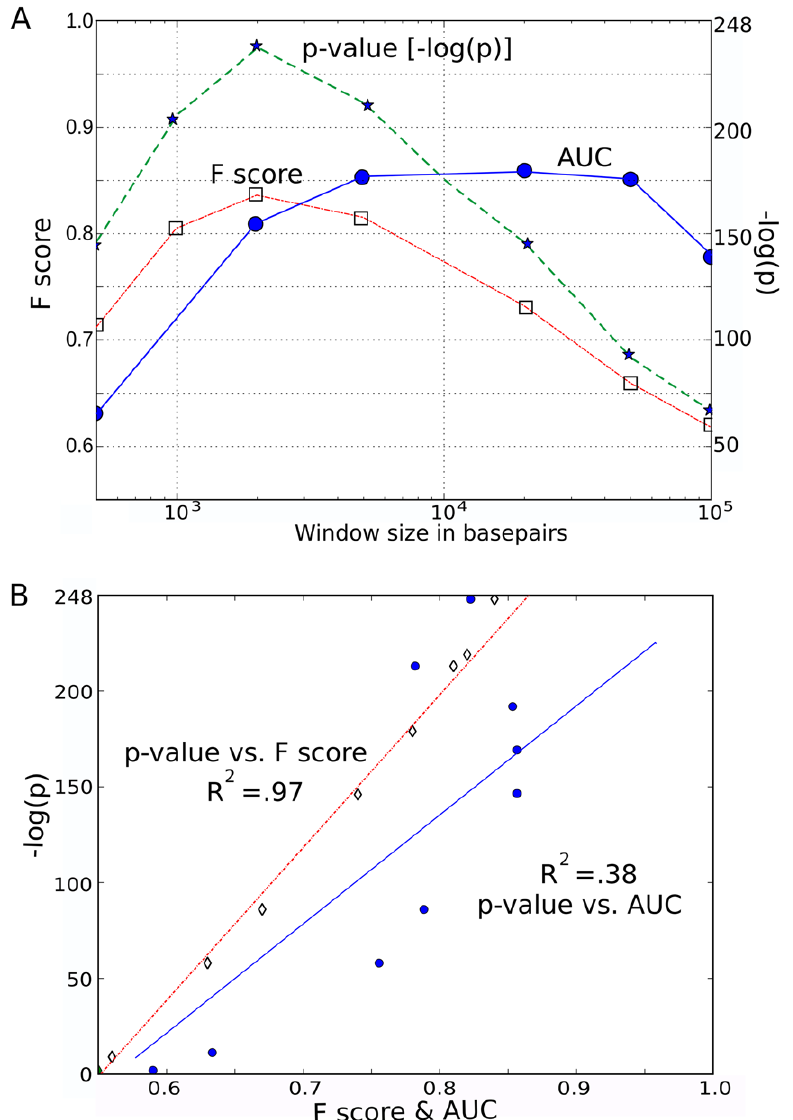
Figure 7. Effect of the window size on F score. ( A ) Plot of Area Under Curve (AUC) or F score (both on left Y scale) or the absolute value of the p- value exponent (right Y scale) for MLV with respect to H3K4me3 as a function of window size in basepairs. ( B ) Pearson correlation for AUC or F score (both on X axis) versus the absolute value of the p-value exponent (Y axis).